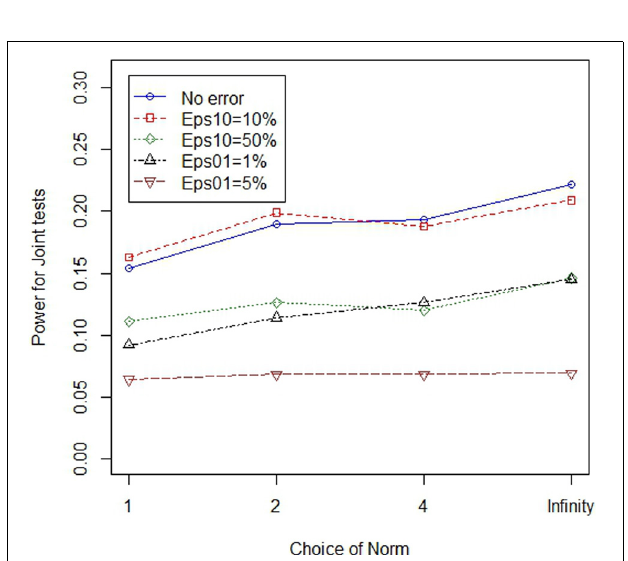
FIGURE 4 | Higher norms are more robust to genotype errors when the proportion of non-causal variants is larger: joint tests. The figure illustrates power of four different (norm) joint statistics, under varying error models. All test statistics experience power loss in the presence of errors. However, power loss can be mitigated through the use of high norm test